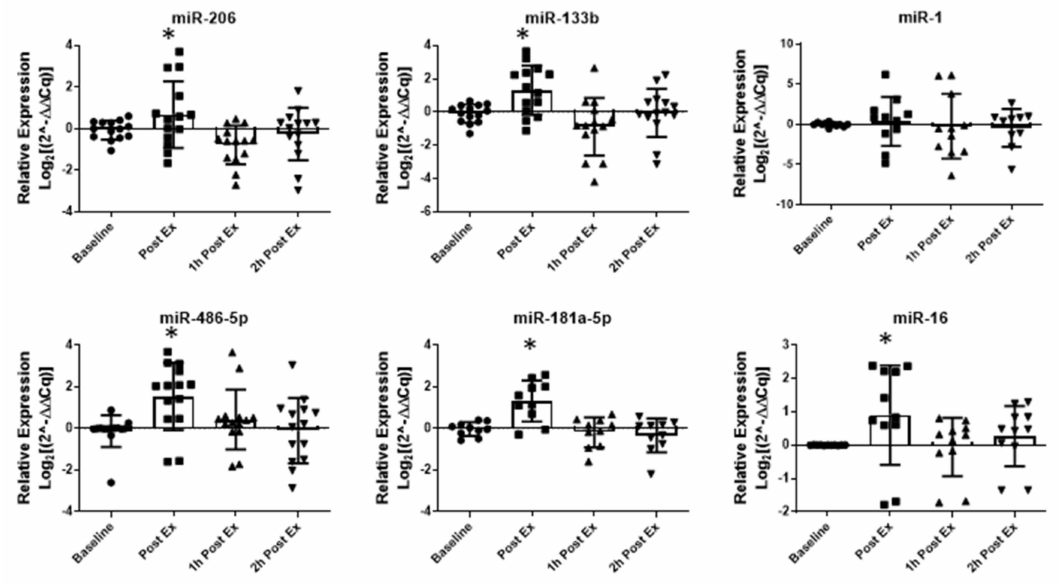
Figure 5. EV-miRNA quantification using real-time PCR following AMAE at baseline condition, immediately (Post Ex), after physical activity and after 1 (1 h Post Ex), and 2 h (2 h Post Ex) from the end of the exercise. MiRNA expression levels were reported as log2(2ˆ − ∆∆ Cq). The results are represented as mean ± SE. * significant difference versus baseline ( p <